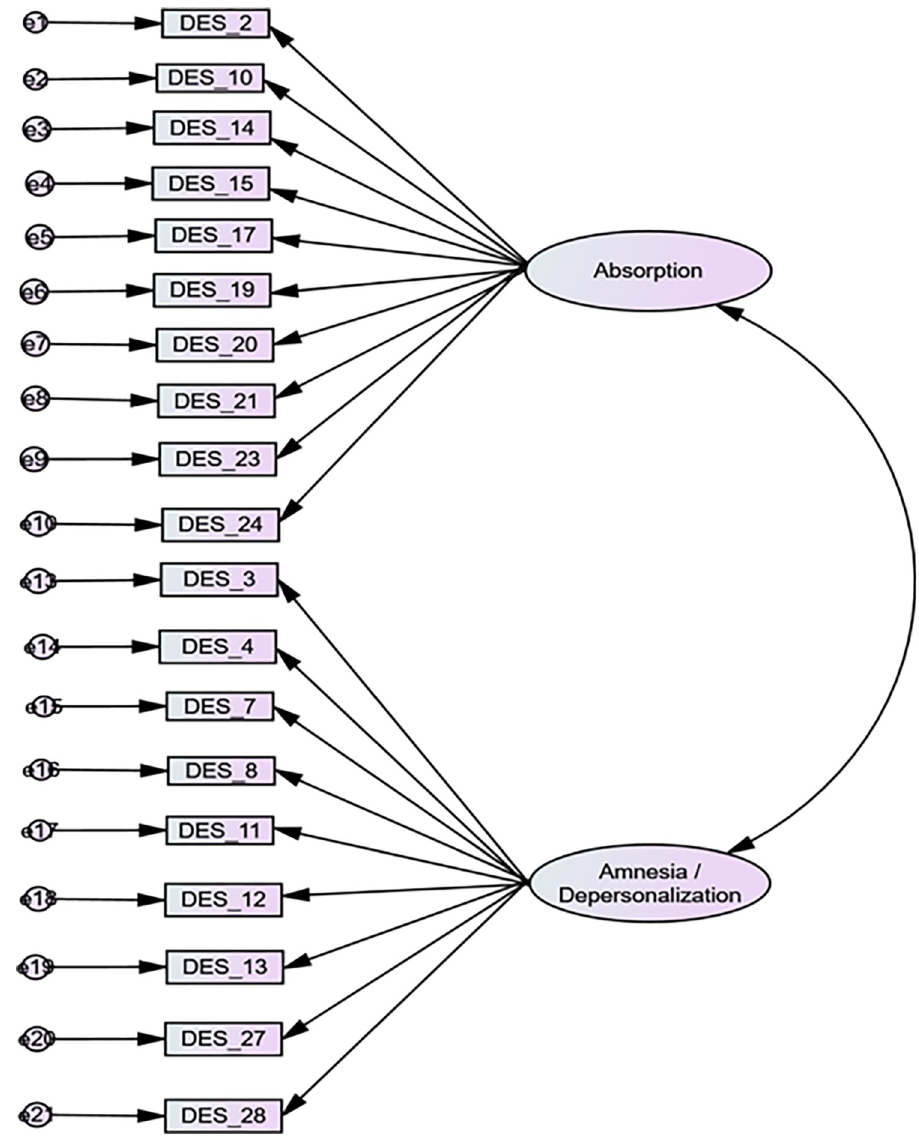
Fig 1. Standardized factor loadings of two-factor model of the Dissociative Experience Scale. � p <